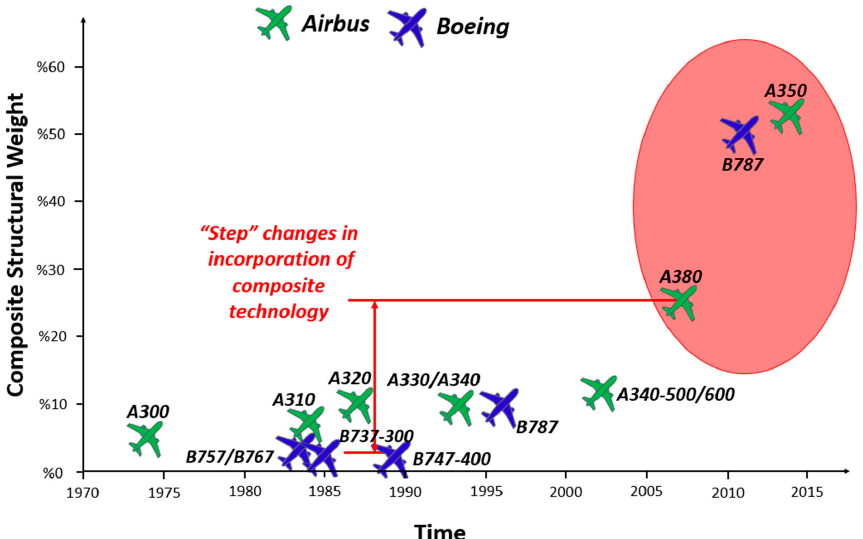
Figure 38. Use of composite materials in aircraft over the years.